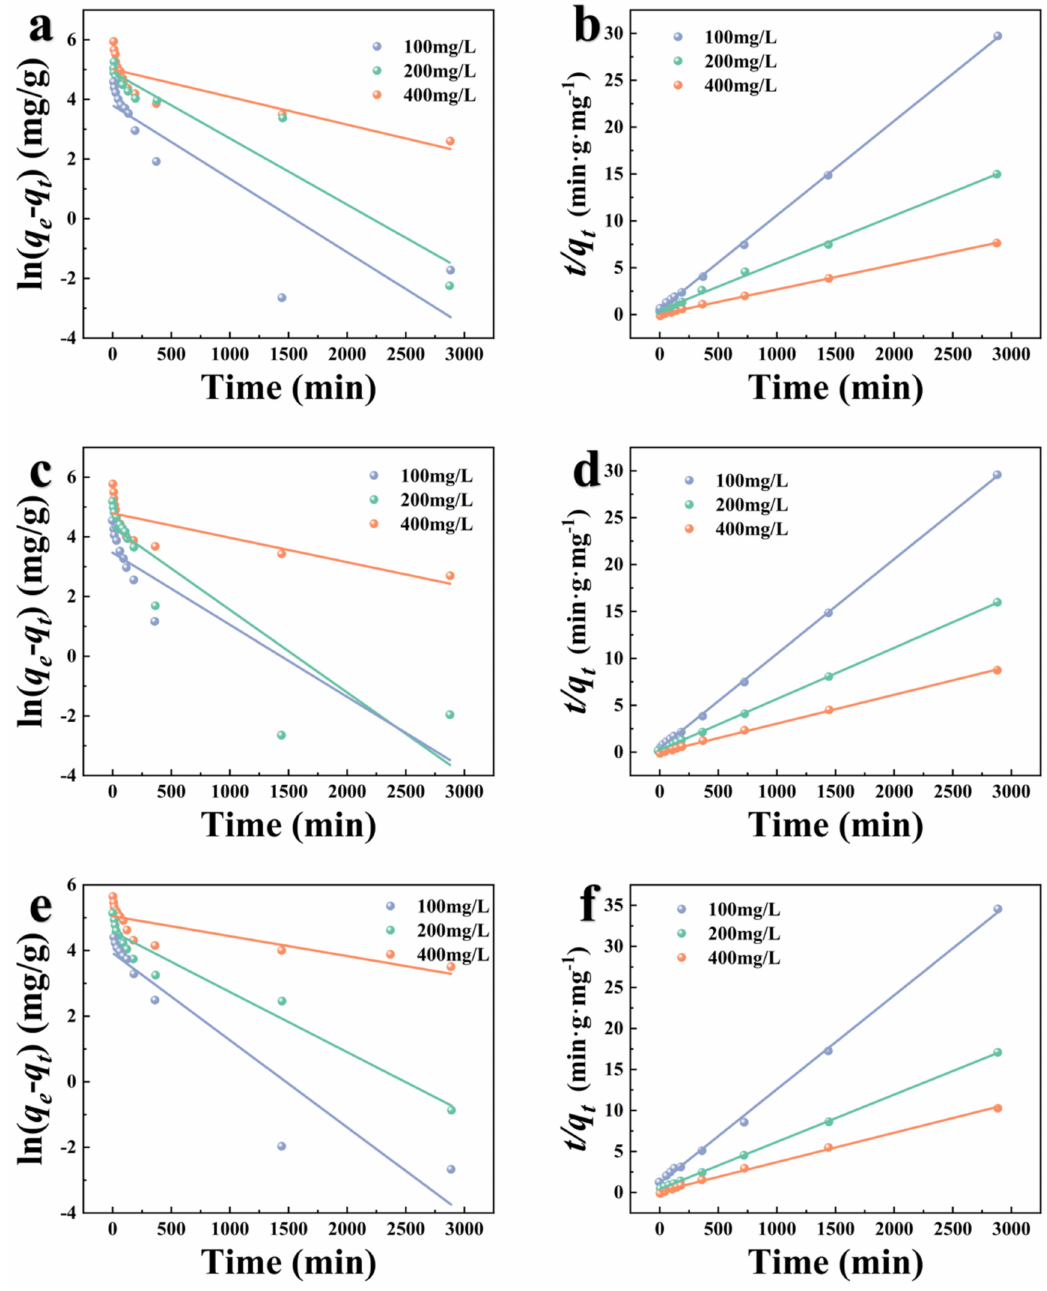
Figure 9. The adsorption kinetics models of TC adsorption on modified crab shell biochar (( a , c , e ) are pseudo − first − order model of K − CSB, P − CSB and M − CSB, respectively; and ( b , d , f ) are pseudo − second − order model of K − CSB, P − CSB and M − CSB,